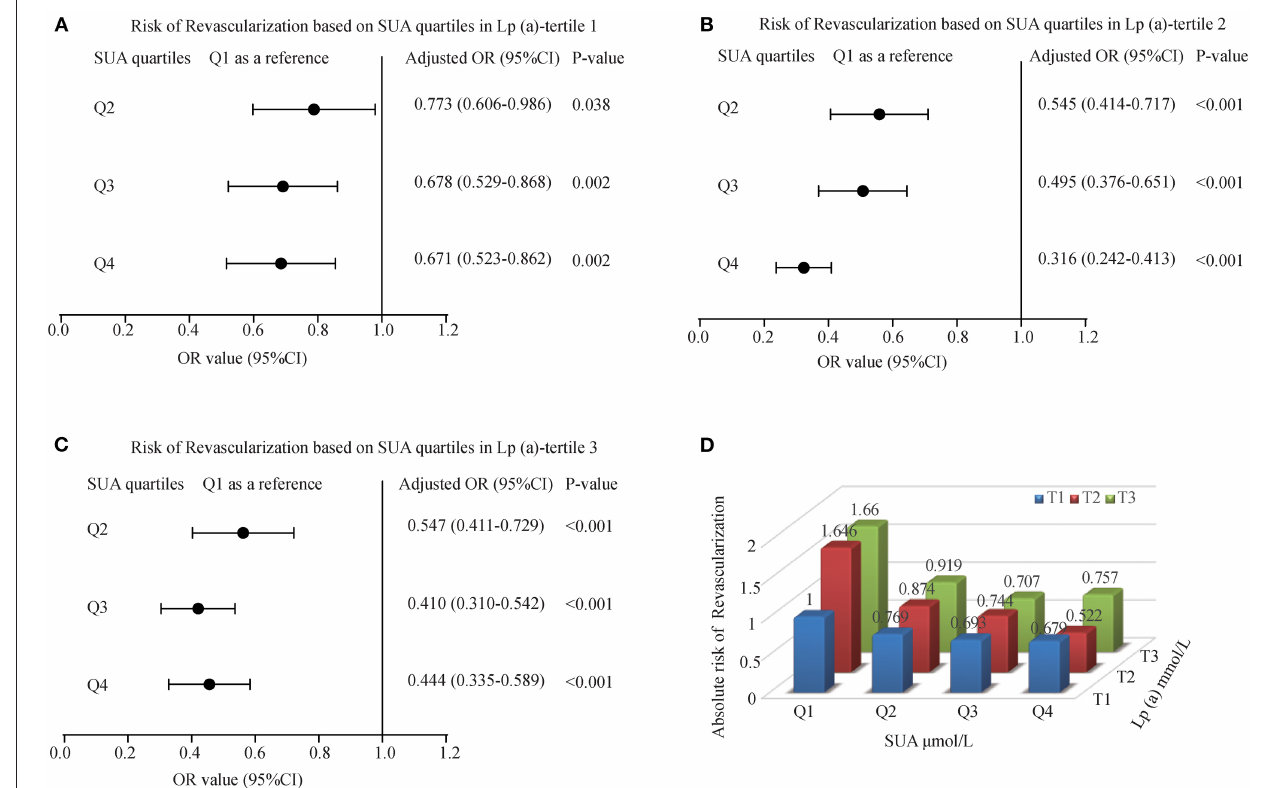
FIGURE 4 | The risk of myocardial revascularization (MRT) based on baseline SUA quartiles in ACS patients. ( A ) Adjusted odd ratios for MRT in Lp(a)-tertile 1; ( B ) Adjusted odd ratios for MRT in Lp(a)-tertile 2; ( C ) Adjusted odd ratios for MRT in Lp(a)-tertile 3; ( D ) Adjusted odd ratios for MRT in each group by quartiles of the SUA and tertiles of the Lp(a). Adjusted for age, gender, smoking, HDL, LDL, TG, Glucose, Creatinine, Statin use, and Hypertension.